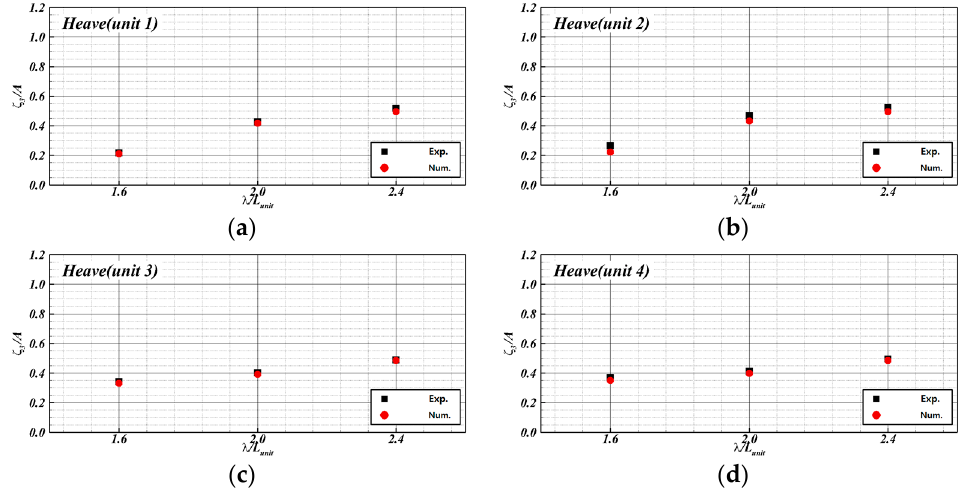
Figure 22. Heave RAOs for 𝑯/𝝀 = 0.05 under head sea: ( a ) Unit 1; ( b ) Unit 2; ( c ) Unit 3; ( d ) Unit 4.